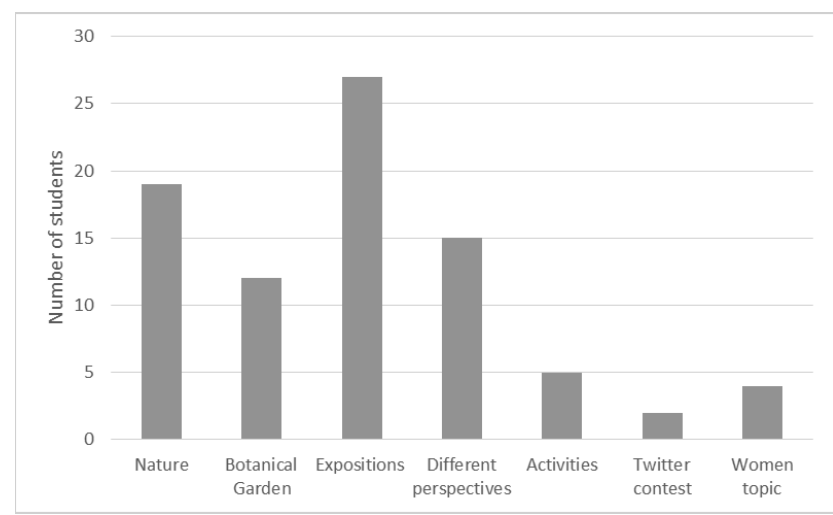
Aspects at the scienti (cid:192) c-literary tour that moved the students. Source: Own